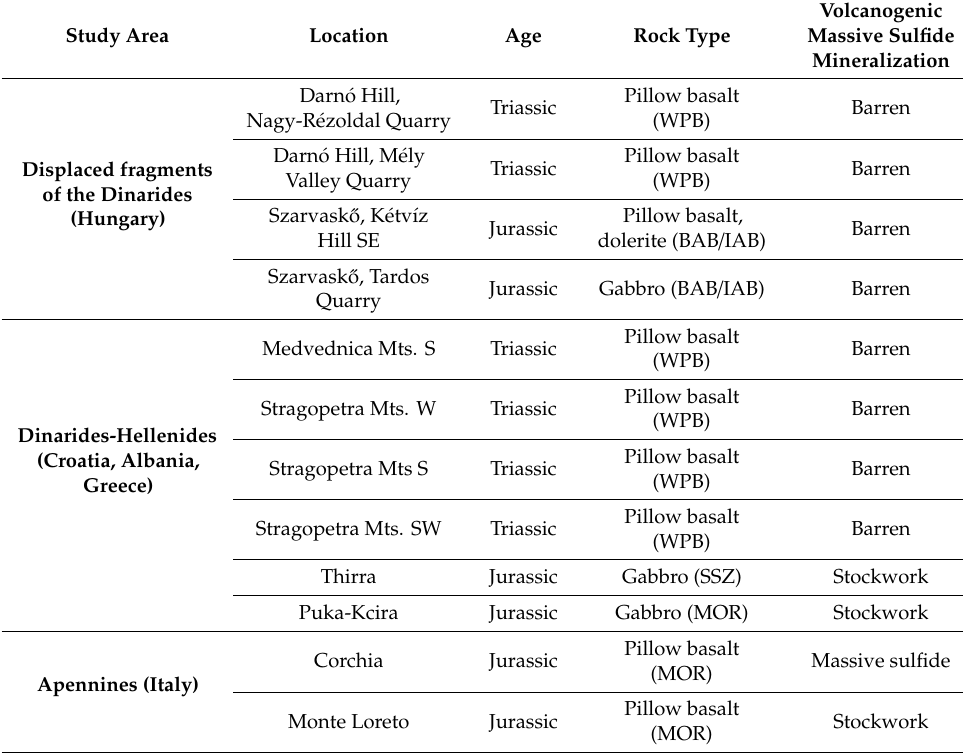
Figure 1. Schematic map showing the Neotethyan ophiolites (black patches) as well as the approximate position of the study locations (red labels) (based on [24]). Table 1. The locations involved in this study.